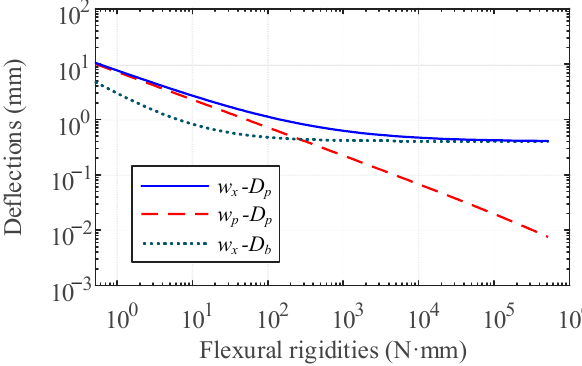
Figure 15. Deflections as a function of flexural rigidities.